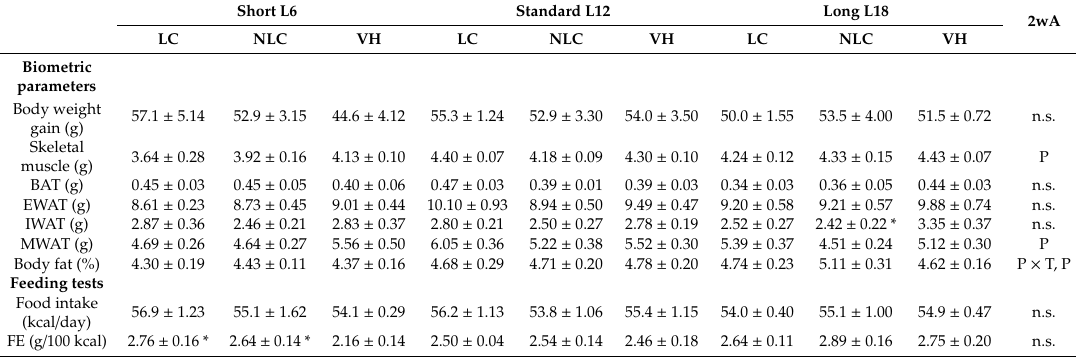
Table 3. Biometric parameters and feeding tests of Fischer 344 rats exposed to three different photoperiods for 7 weeks and supplemented with local sweet cherry (LC), non-local sweet cherry (NLC), or vehicle